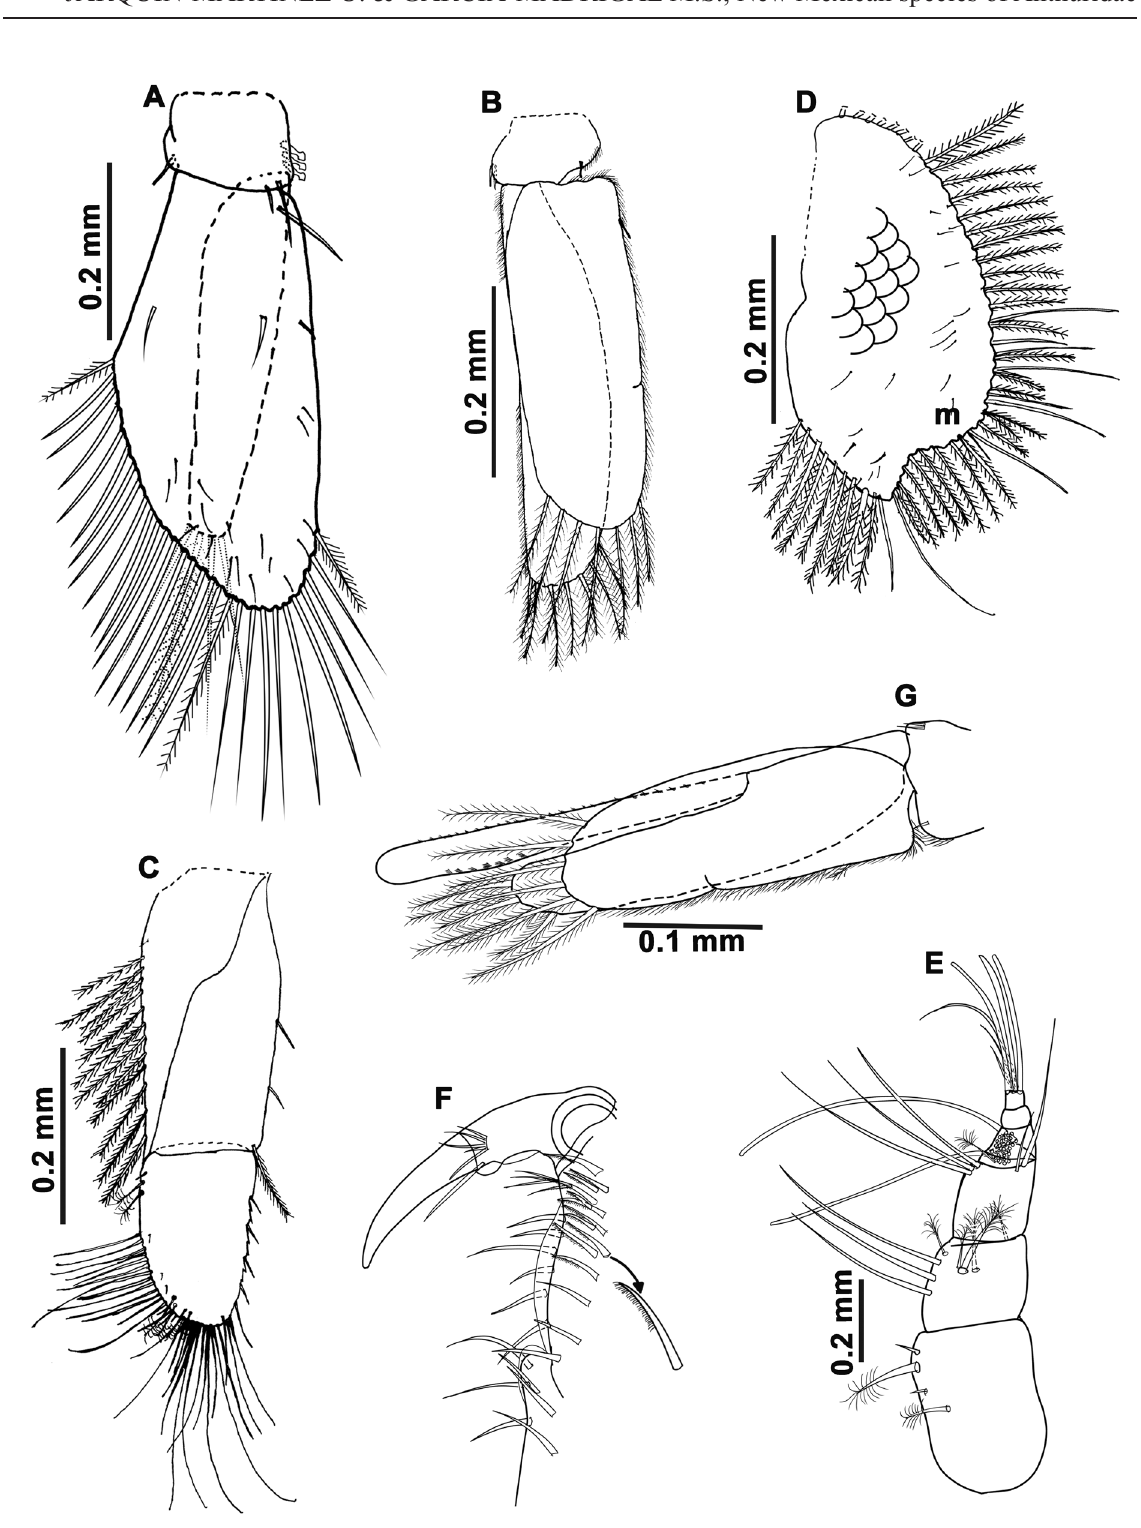
Fig. 19. Tinggianthura mexicana sp. nov. A–D . Holotype, ♀, 3.7 mm, Oaxaca, Huatulco, El Maguey Bay (UMAR-PERA 561). A . Pleopod 1. B . Pleopod 2. C . Uropodal endopod. D . Uropodal exopod. E–G . Paratype, ♂, 3.9 mm (UMAR-PERA 562). E . Antennule. F . Pereopod 1. G . Pleopod